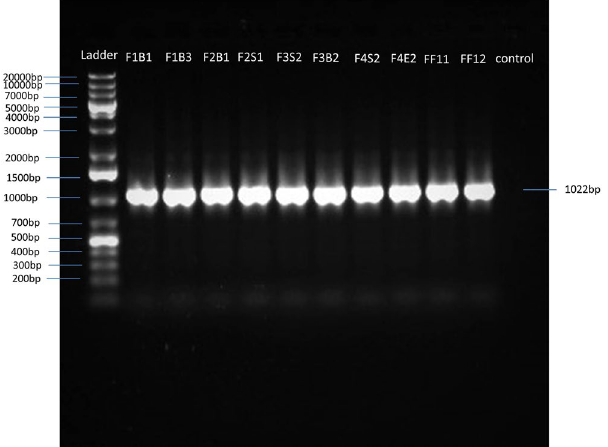
Figure 1. PCR amplification of E . faecalis isolates with specific forward (Efac F1) and universal reverse (1492R) primer. Ladder, 1 kb plus DNA ladder.